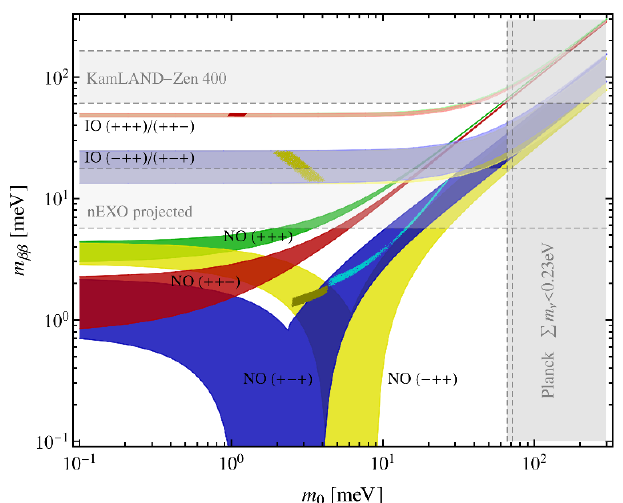
Figure 1 . The colored strips indicate m (cid:12)(cid:12) as a function of the lightest neutrino mass m 0 for generic CP (cid:22)(cid:28) neutrino mass matrix for di(cid:11)erent cases of CP parities and mass orderings [13]. Small darker (lighter for blue) regions inside the colored strips mark the solutions for our cases IV, III, II and I (from top to bottom) shown in table